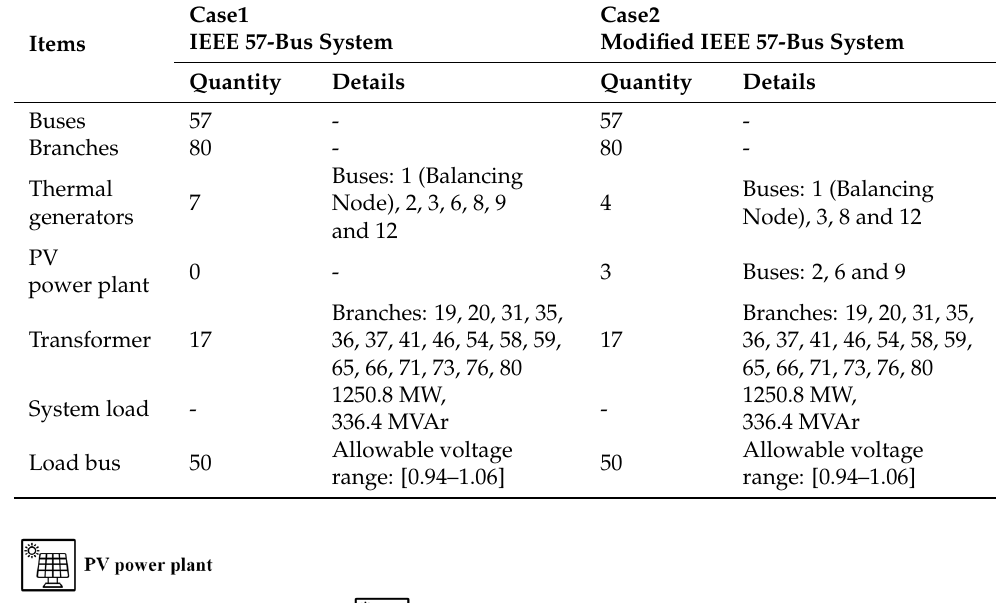
Table 1. The system information.